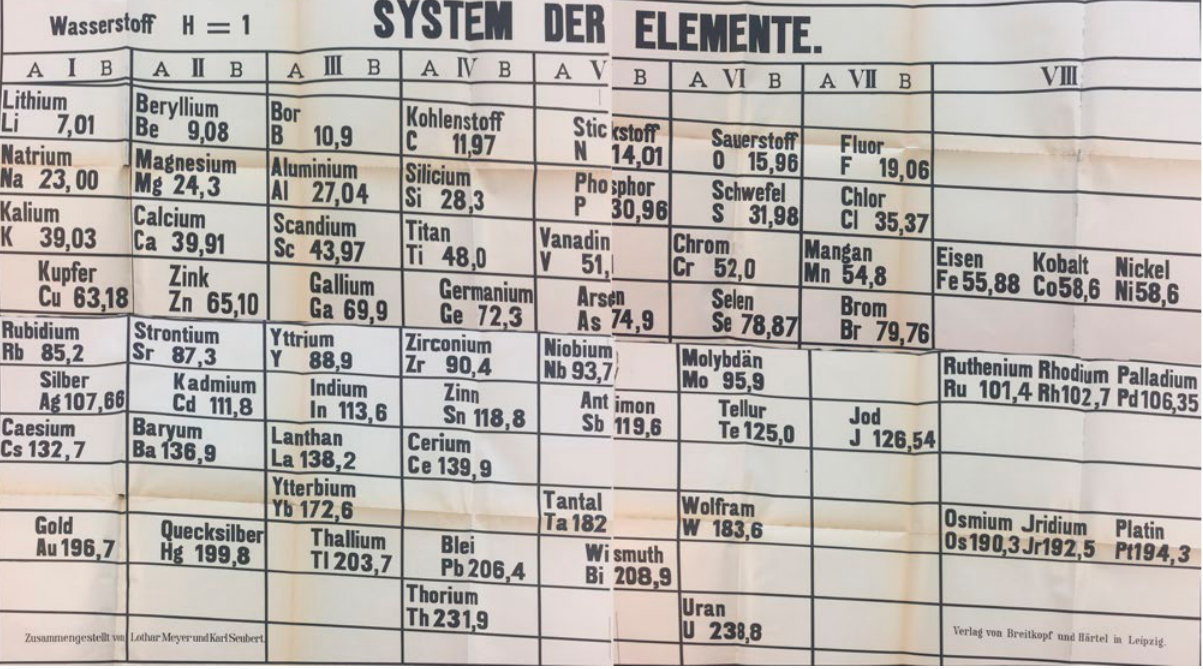
Figure 9. Meyer‘s system of elements as chart. Combination of four individually printed unbounded parts. Scan from L. Meyer, K. Seubert, Das natürliche System der Elemente. Nach den zuverlässigsten Atomgewichtswerthen zusammengestellt . 2 nd edition, Breitkopf&Härtel, Leipzig, 1896